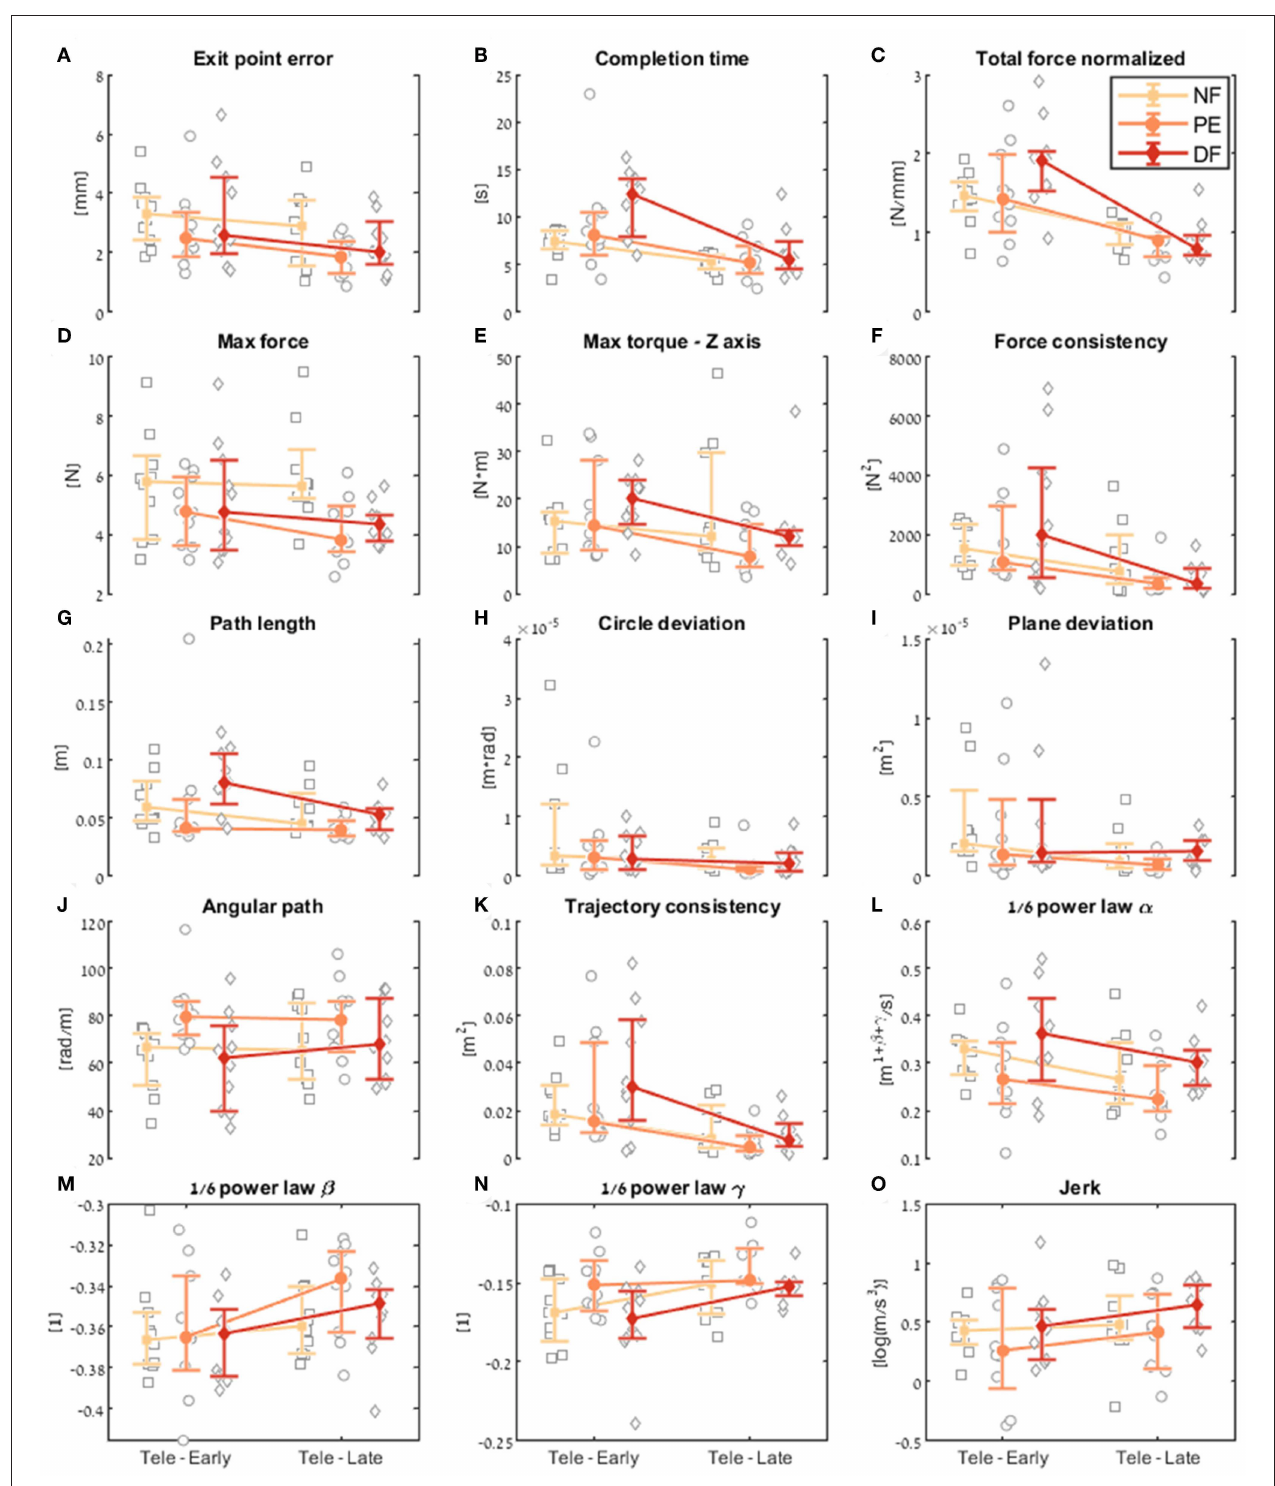
FIGURE 9 | Comparison of the performance of the insertion subtask between early and late dVRK teleoperation. For each metric (A–O) , median of first five (early) and last five (late) trials are presented. Each gray marker represents an individual subject. The big marker with error bars shows the median of each group (NF, PE, and DF) and the 95% bootstrap confidence interval,